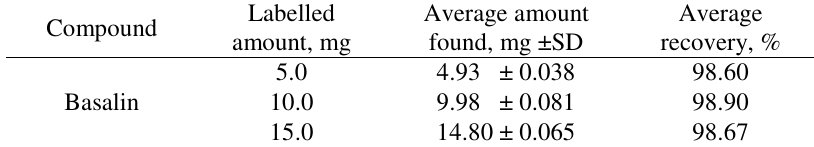
Table 5. Determination of fluchloralin in agricultural formulations; pulse amplitude: 50 mV, Drop time: